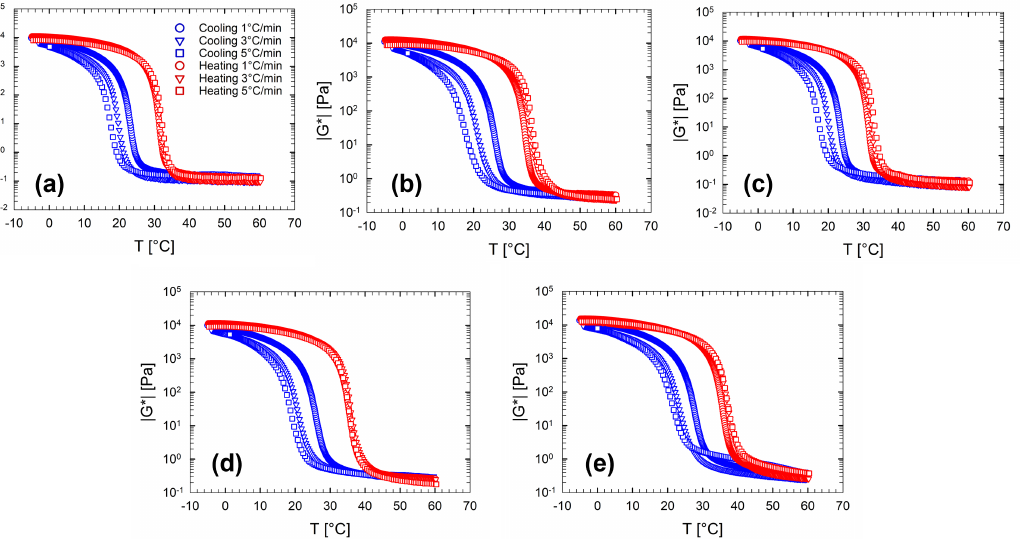
Figure 2. Complex modulus, G ∗ | | , as a function of the temperature at different cooling/heating rates for multi-component aqueous gelatin solutions. ( a ) Sol. 2; ( b ) Sol. 3S; ( c ) Sol. 3D; ( d ) Sol. 4; ( e ) Sol. 5. The legend in Figure ( a ) is valid for all figures.